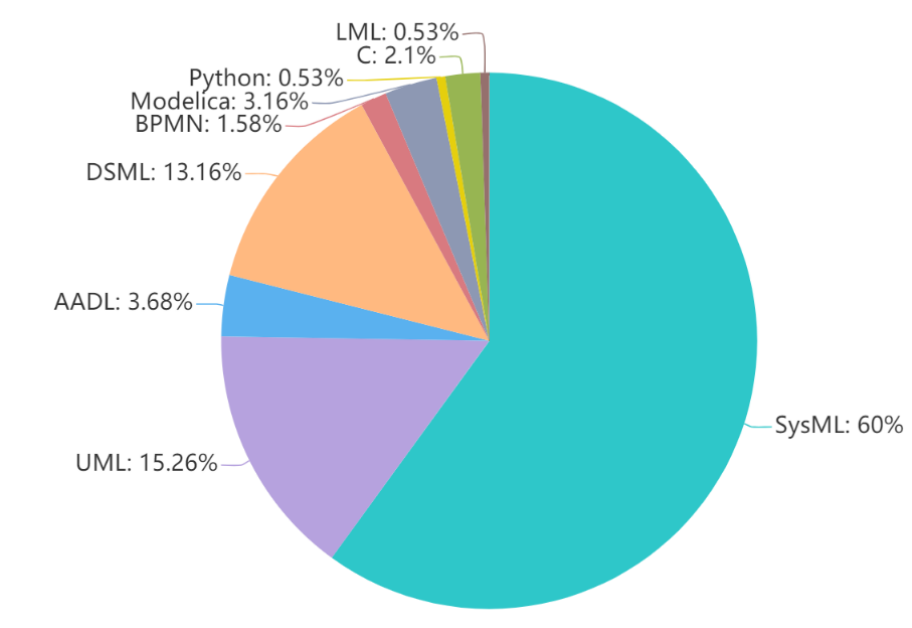
Figure 9. Languages used in the